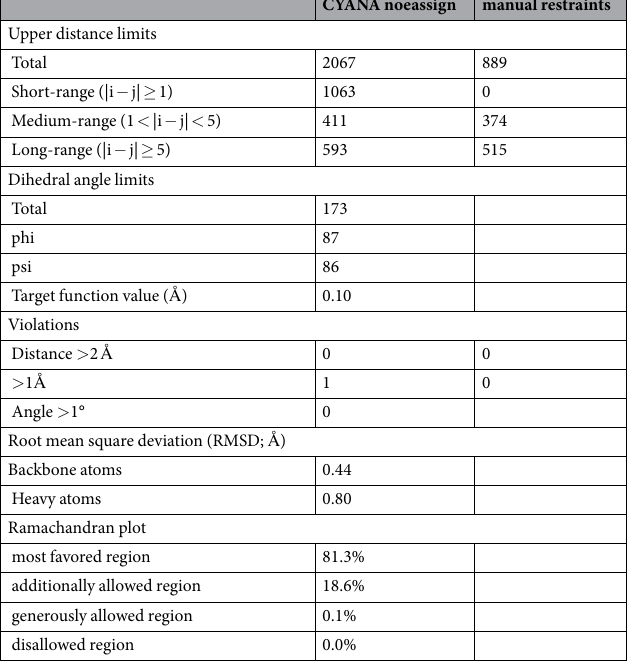
Table 1. CYANA structure calculation statistics.